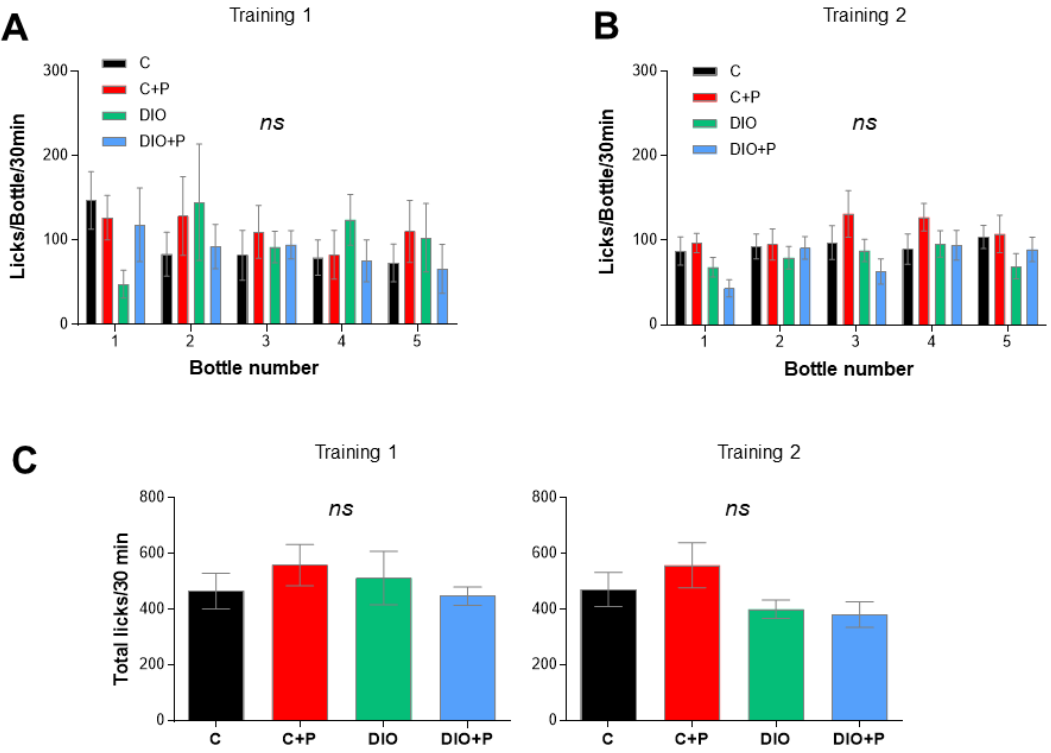
Figure 4. Gustometer analysis: training sessions in mice subjected to a regulatory chow or an obesogenic diet alone (C and DIO) or supplemented with 10% Prebiotic (C+P and DIO+P). 20 h water-deprived mice were subjected to 2 training sessions before the taste-testing sessions (30 min, each). ( A ) Training 1: Each mouse had a free access to the 5 bottles filled with water in order to determine the licking rate/bottle/30 min. It is time of adaptation to a new environment; ( B ) Training 2: Each learned to drink water according to the protocol used during the brief-access taste testing, i.e., a random and intermittent opening of shutters. The licking rate/bottle/30 min was determined; ( C ) Total licks for 30 min during the training 1 and 2. Mean ± SEM. 2-way ANOVA + Tukey HSD. ns non-significant. C, C+P, DIO, n = 10. DIO+P, n = 8.